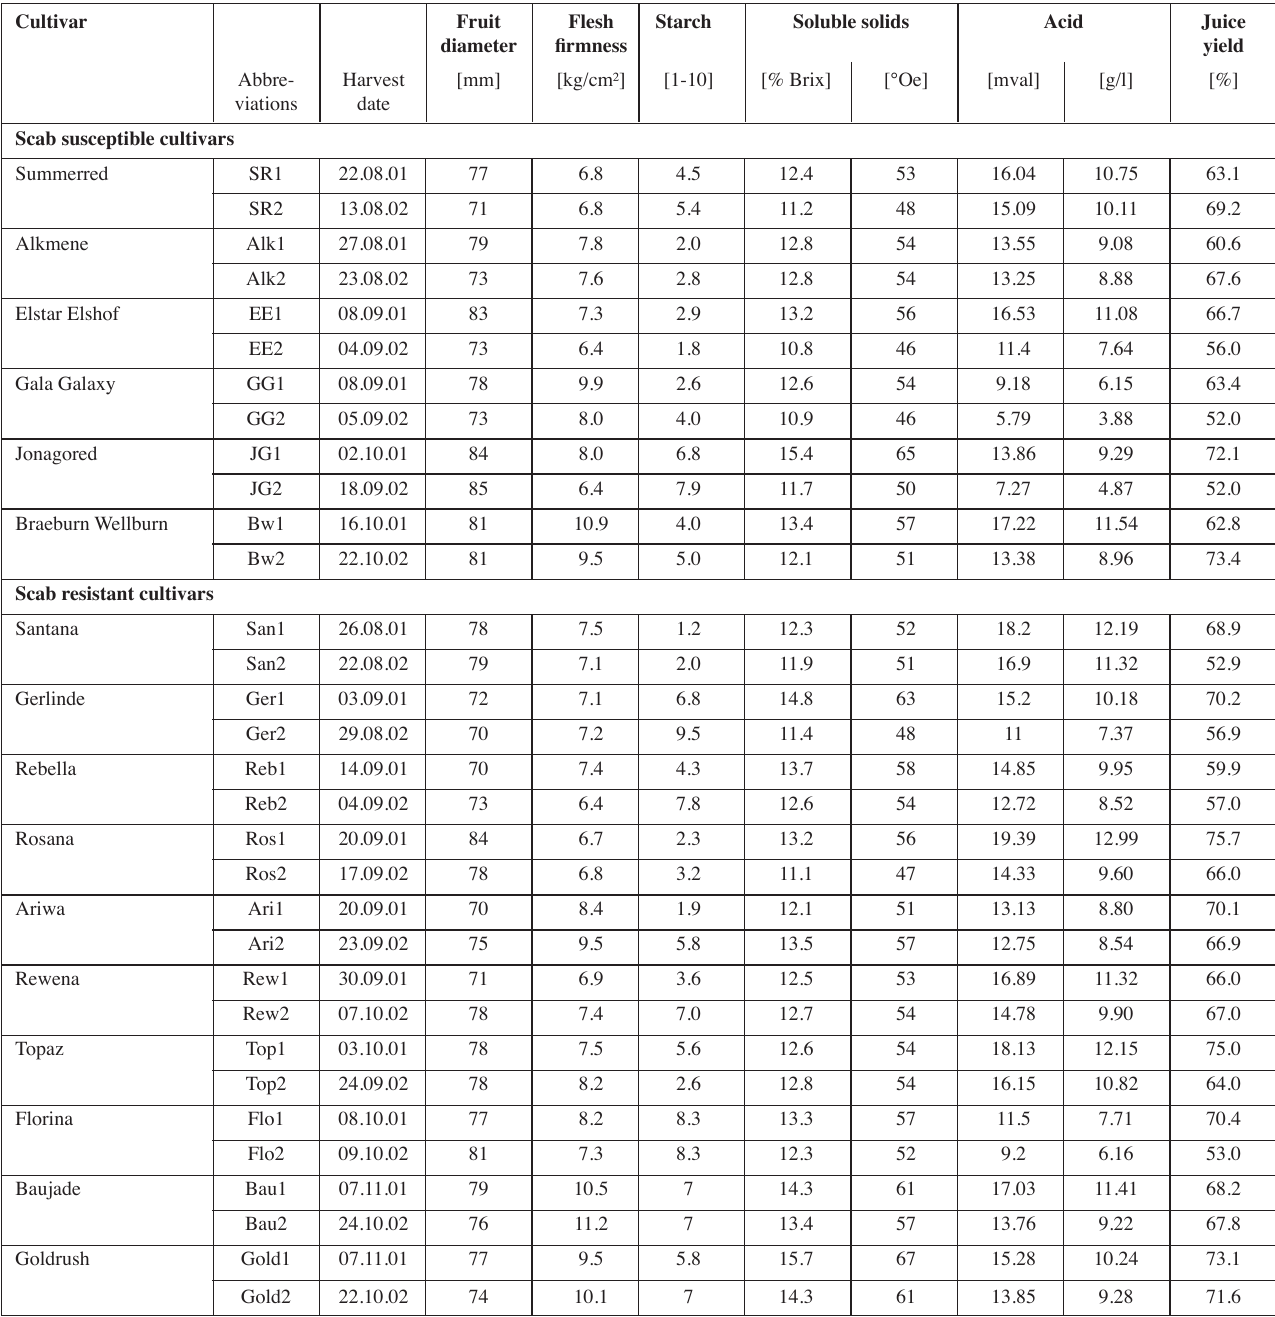
Tab. 1: Properties of apple fruits harvested in 2001/2002